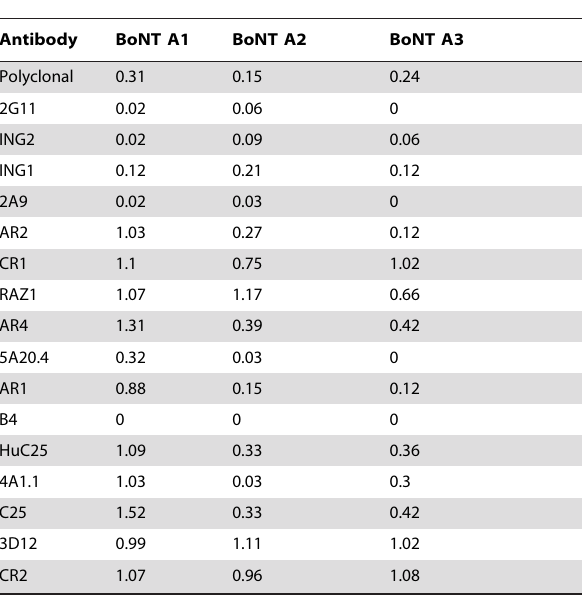
Table 3. Peak area ratios of the peptide cleavage product over the internal standard peptide obtained from the Endopep-MS reaction of BoNT A after its extraction by the antibody